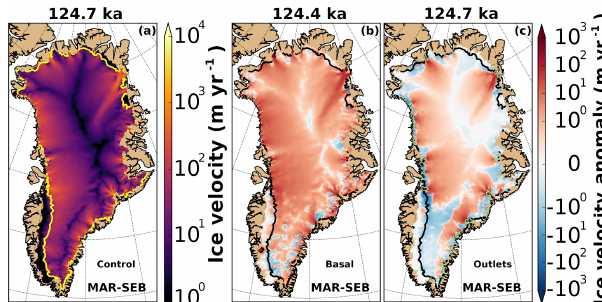
Figure 9. Ice velocity of the ice sheet in the control experiment (a) and the basal × 0 . 9 ( b ; reduced friction of the entire ice sheet), and the outlets × 0 . 5 ( c ; reduced friction at outlet glaciers) experi- ments at their respective ice sheet minimum (time indicated at the top of the panels). Anomalies are relative to the control experiment. The ice margin is indicated with a solid yellow/black line (10m ice thickness remaining). A nonvisible ice margin is identical to the domain margin. The outlet regions are indicated with bright green contours (c)